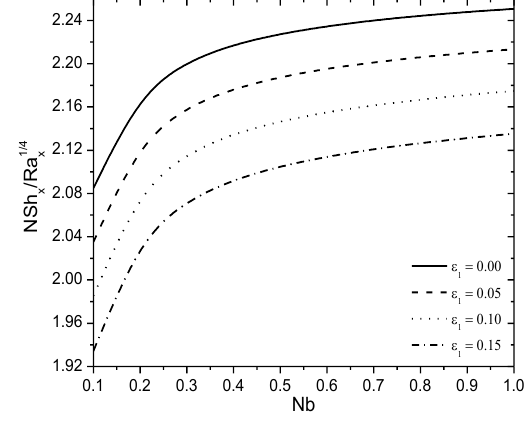
 on the Local nanoparticle 1 Sherwood number